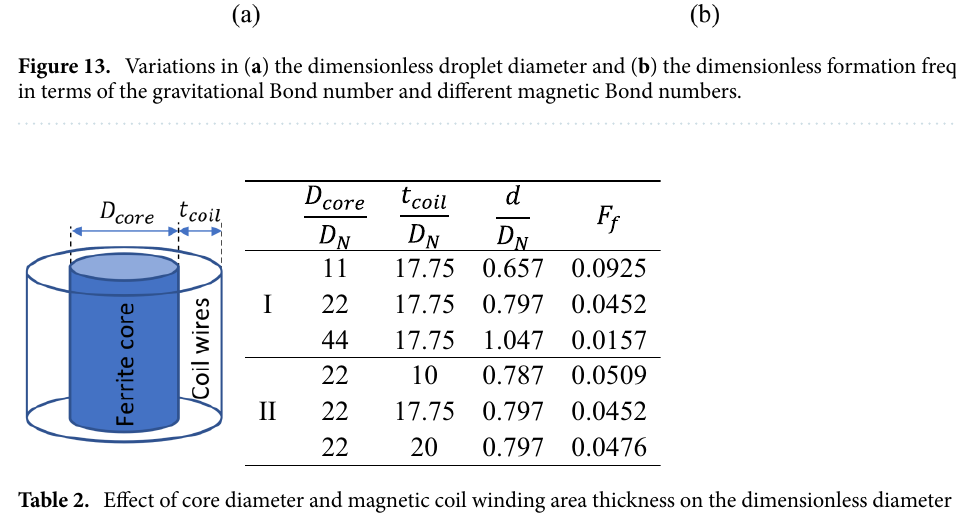
Table 2. Effect of core diameter and magnetic coil winding area thickness on the dimensionless diameter and formation